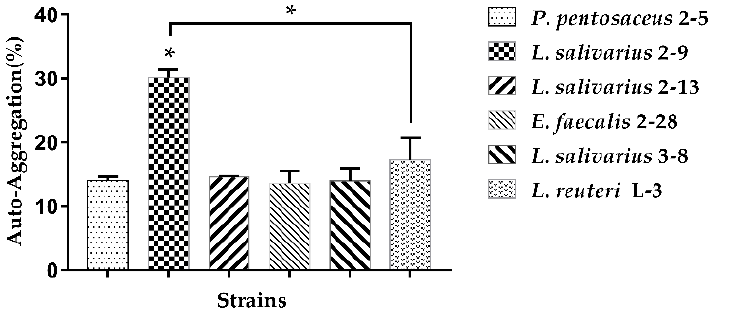
Figure 2. Auto-aggregation of strains determined after 4 h of incubation at 37 °C. The results represent the mean ± SD of three independent experiments. The significant difference was indicated by asterisks compared to P. pentosaceus 2-5: * p <0.05.